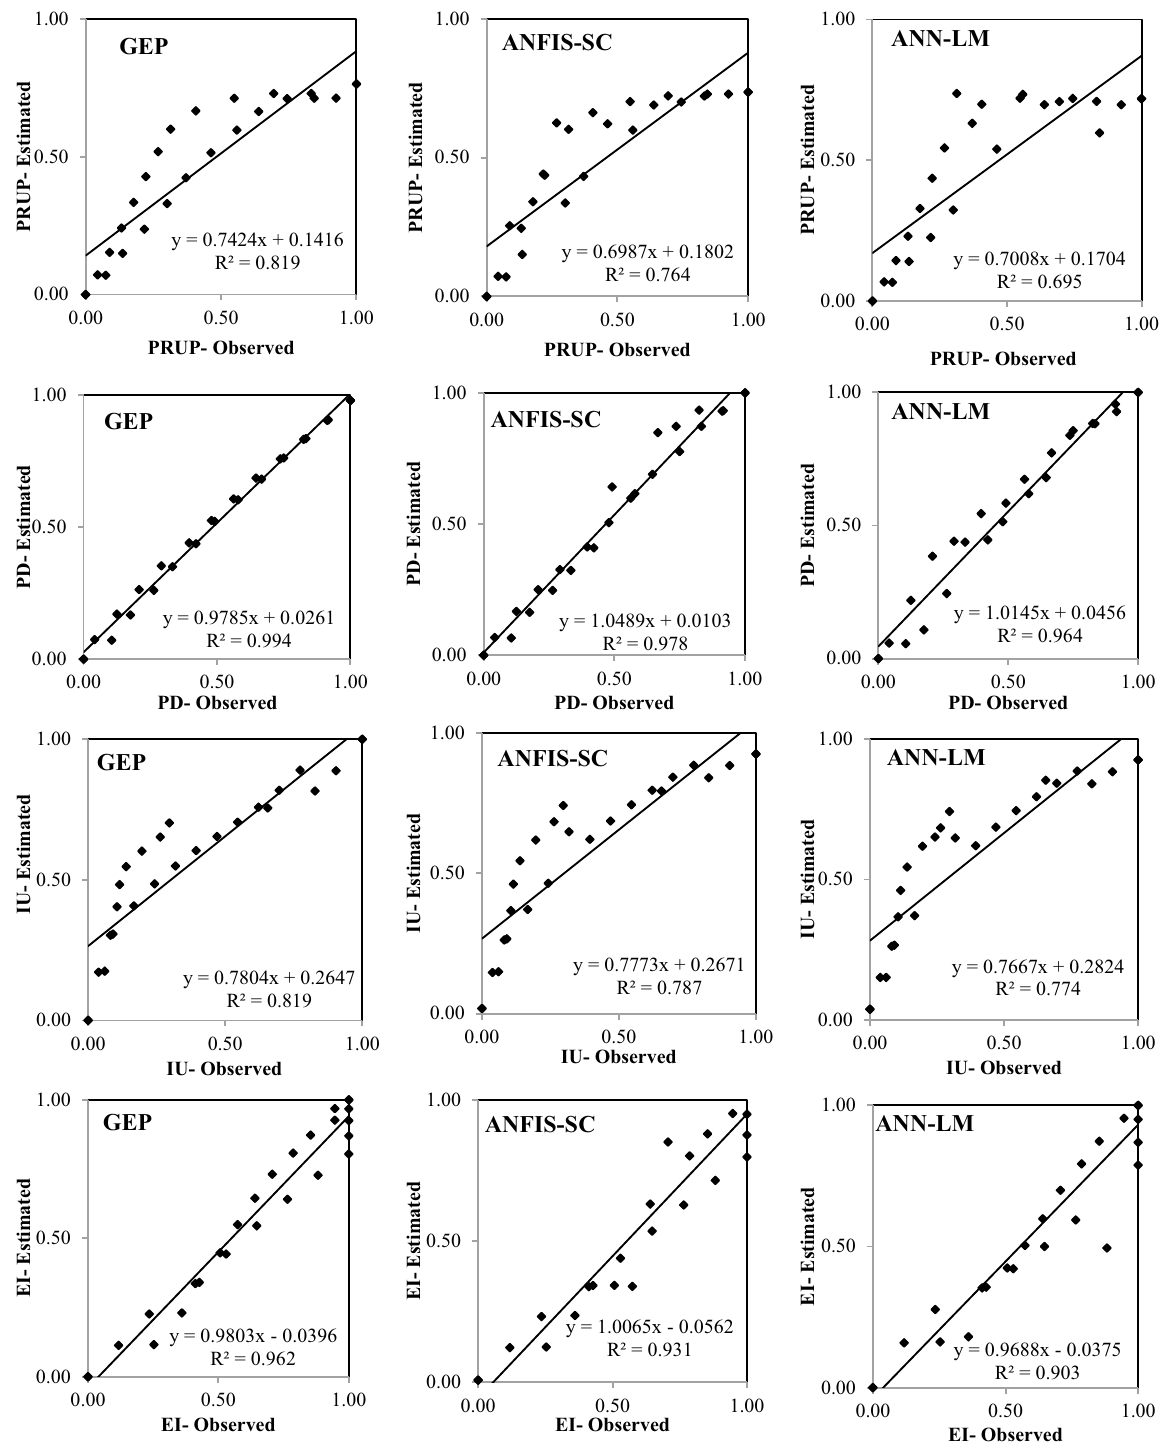
Figure 10. Observed and estimated social indicators during the testing period in